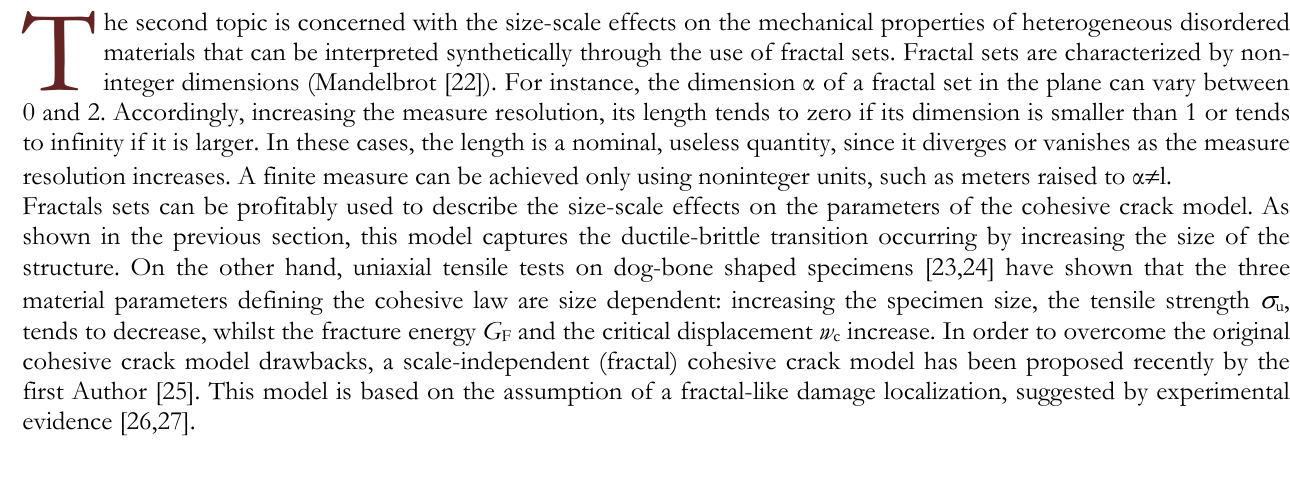
Figure 2: Dimensionless load vs. deflection diagrams by varying the brittleness number S initially uncracked (a) and cracked (b)